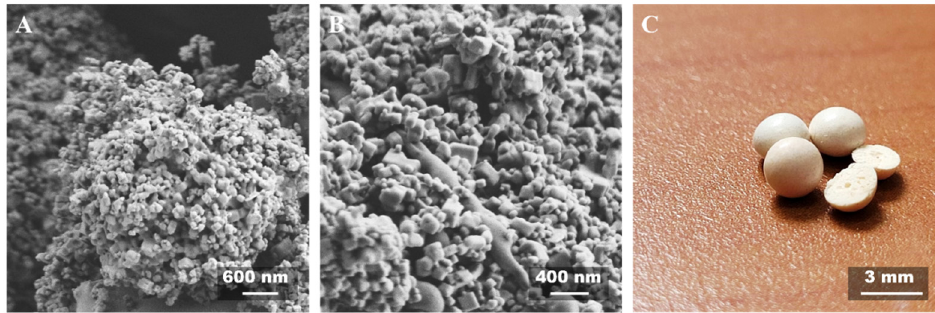
Figure 4. High-resolution scanning electron microscopy (HRSEM) images of ZnHCF. ( A ) SEM images of ZnHCF powder. ( B ) SEM images of PES-ZnHCF beads. ( C ) PES-ZnHCF beads.